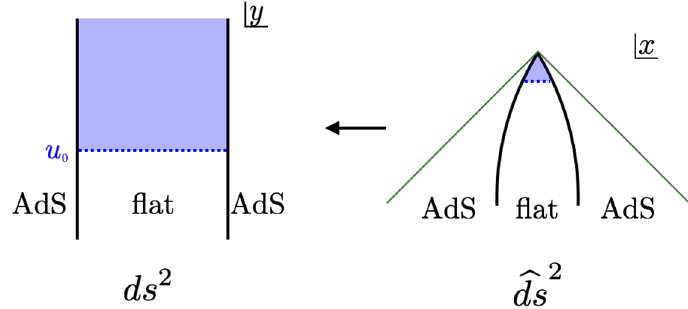
Figure 5. On the left, the flat strip is a rectangle in y coordinates. An infinite rectangle given by u > u 0 is squeezed into a small finite volume in Poincare x coordinates. This is the source of the large conformal factor in (4.19). A similar squeezing occurs in the connected history, except that we consider global rather than Poincare